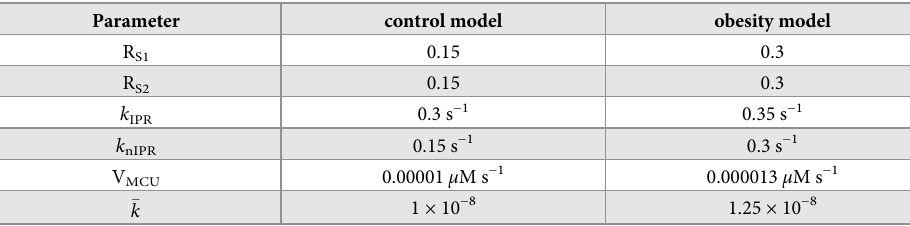
Table 2. Modified parameters for the obesity model